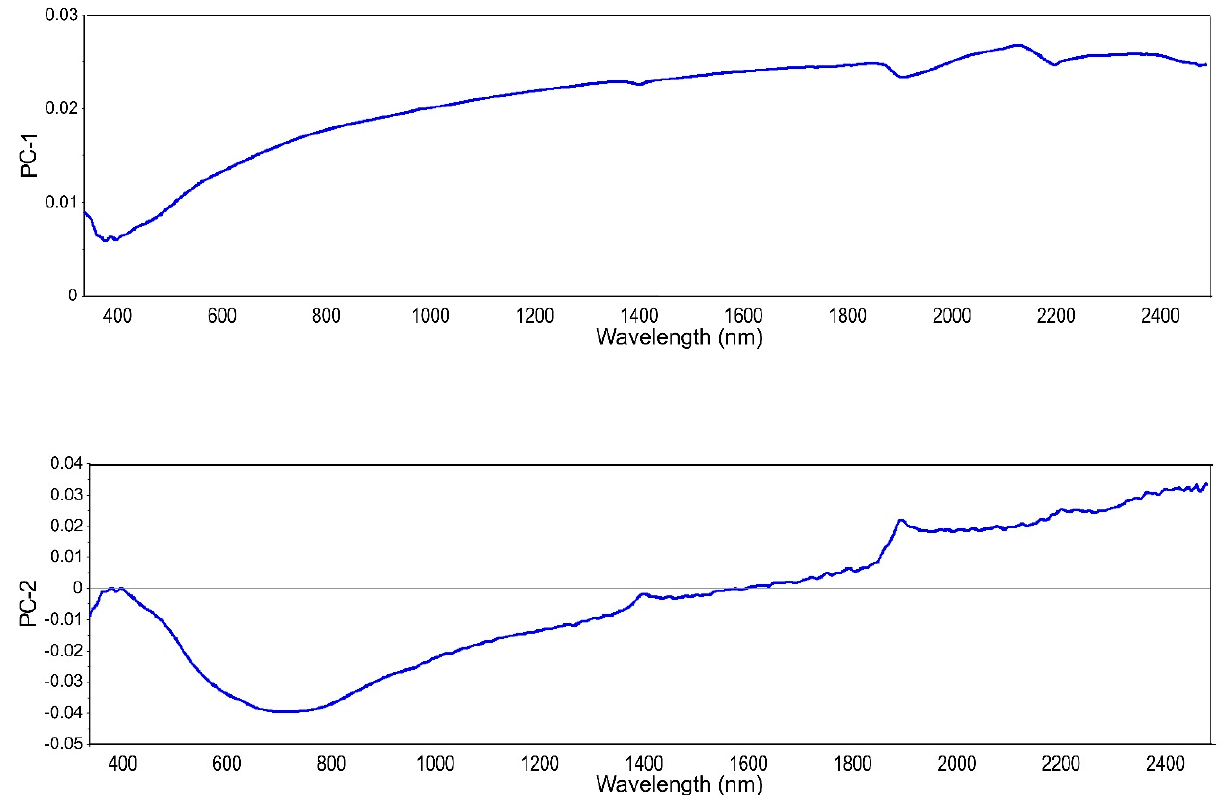
Figure 4. Loading weights for the first two principal components PC-1 and PC-2.